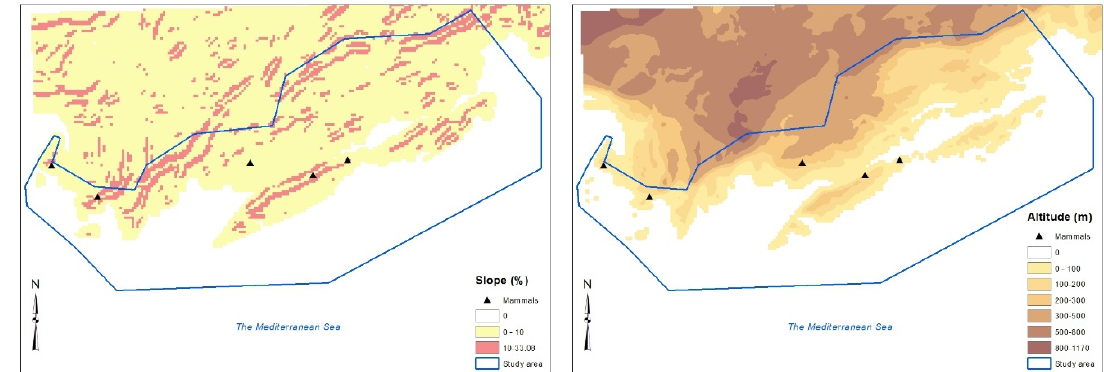
Figure 7. The distributions of vulnerable mammals observed by field work on the slope ( left ) and altitude range ( right ) maps.